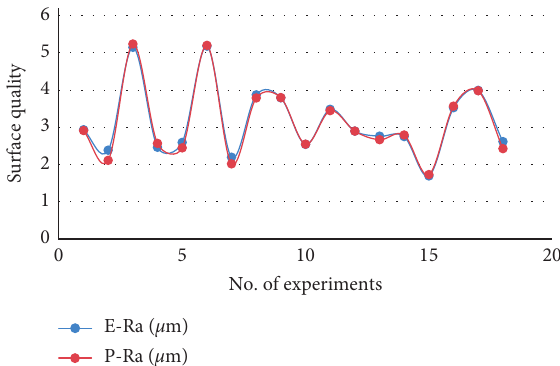
Figure 10: Performance comparison of obtained values of E-Ra and P-Ra for number of samples.